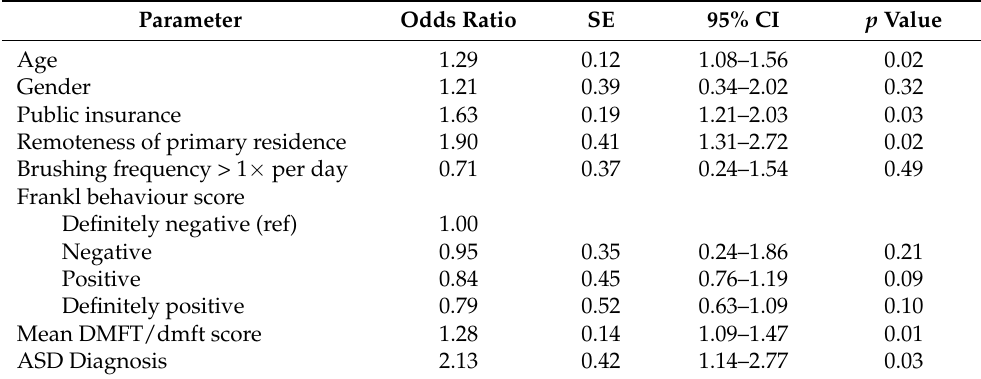
Table 3. Logistic regression model assessing predictors for general anesthesia